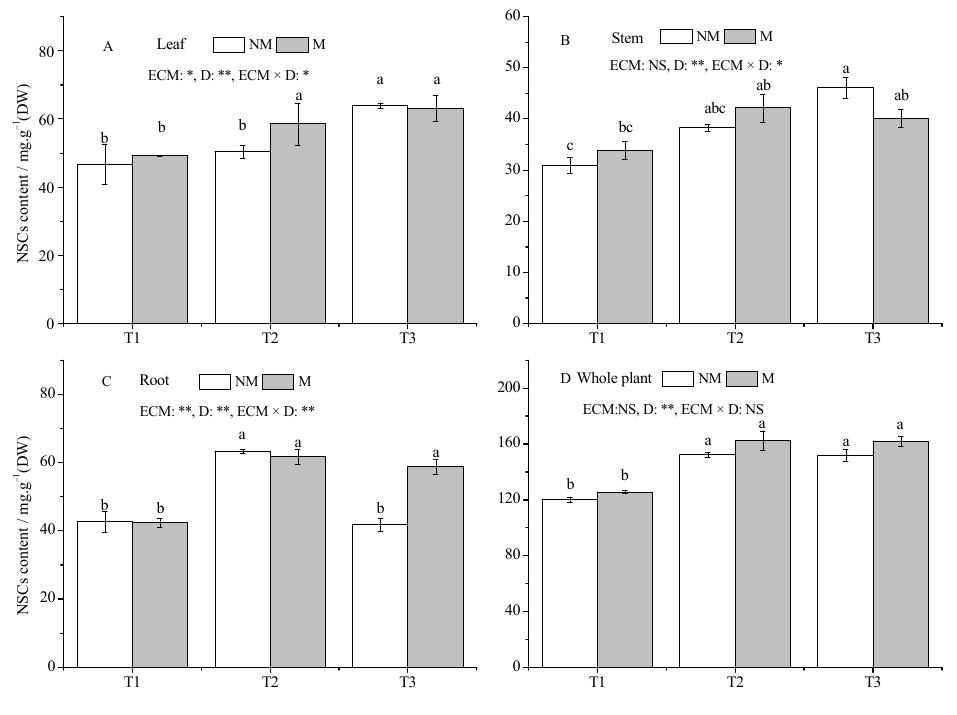
Figure 6. Effect of ECMF and drought on the NSCs contents of various tissues and whole plants of P. massoniana. Values (means ± SEs) followed by different letters among treatments indicate significant differences at the 5% level, and the same letter indicates no significant difference. NS, not significant, * p < 0.05; ** p < 0.01. T1, well-watered, T2, moderate drought, and T3, severe drought. NM, no Sl inoculation, M, Sl inoculation. D, drought treatment. The letters denote ( A ) leaf NSCs (non-structural carbohydrates); ( B ) stem NSCs; ( C ) root NSCs; ( D ) whole plant NSCs. Compared with the T1 treatment, the T2 and T3 treatments signi fi cantly decreased the SS/St ratio of leaves in NM seedlings, whereas the T3 treatment signi fi cantly increased the SS/St ratio of roots and whole plants in M seedlings ( p < 0.05) (Figure 7A,C,D). In addition, no signi fi cant e ff ect of water de fi ciency on the SS/St ratio of other tissues and whole plants of both NM and M seedlings was found (Figure 7A–D). It is likely that Sl had no e ff ect on the SS/St ratio in all treatments, except a signi fi cant increase in leaf and whole-plant SS/St ratio was detected in the T3 treatment compared with NM seedlings( p < 0.05) (Figure 7A,D).